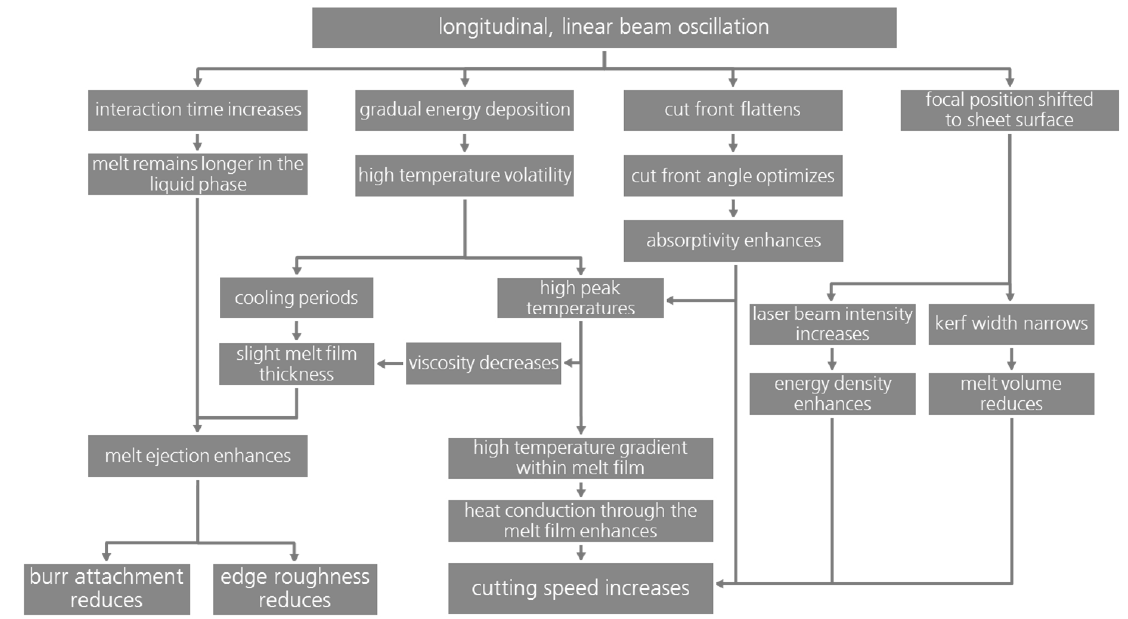
Figure 22. Abstract representation of the explanatory model.